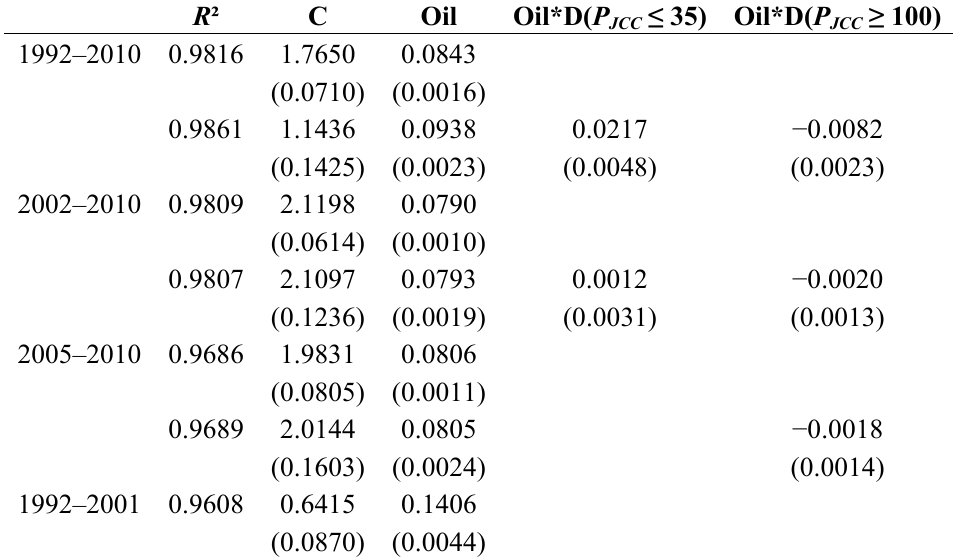
Table 3. Fully modified OLS estimates of LNG